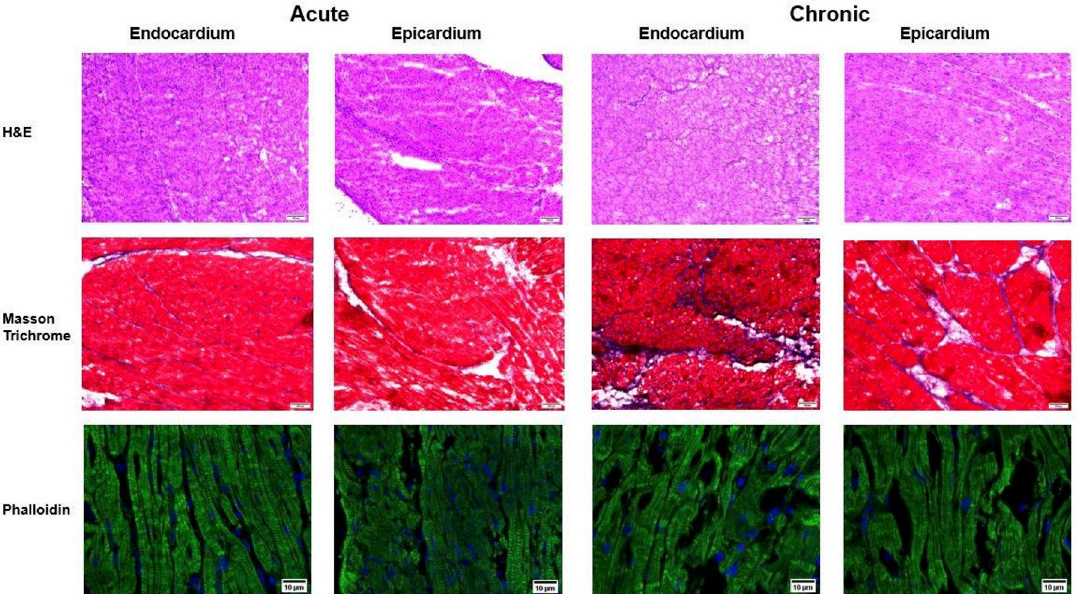
Fig 6. Histological analysis of atrial fibrosis and actin filament alignment. Endocardial and epicardial tissue sections taken from the left and right atrium were stained with Hematoxylin and Eosin, Masson’s-Trichrome, and Phalloidin to compare the degree of fibrosis between paroxysmal and persistent AF. Both the endocardium and epicardium experienced an increase in fibrosis after six weeks of persistent AF. Phalloidin staining for F-actin demonstrated decreased myocardial fiber alignment and loss of anisotropy in persistent AF tissue. Scale bar 50um.